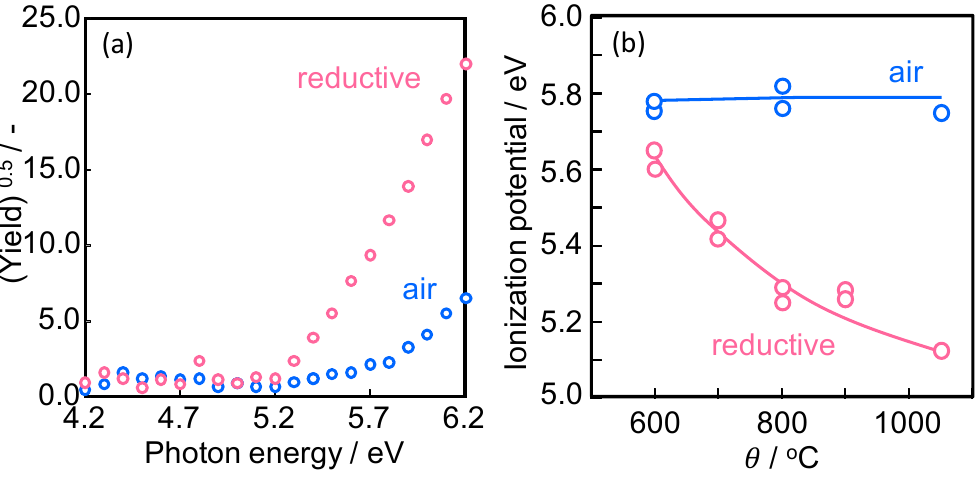
Figure 7. ( a ) Relationship between the square root of the photoelectric quantum yield ( Y 1/2 ) and the photon energy of the specimens heat-treated at 800 °C in air or in Ar containing 4% H 2 . ( b ) Dependence of the ionization potential of the catalysts prepared at 600, 800, and 1050 °C in air, and 600, 700, 800, 900, and 1050 °C in Ar containing 4% H 2 on the heat treatment temperature,